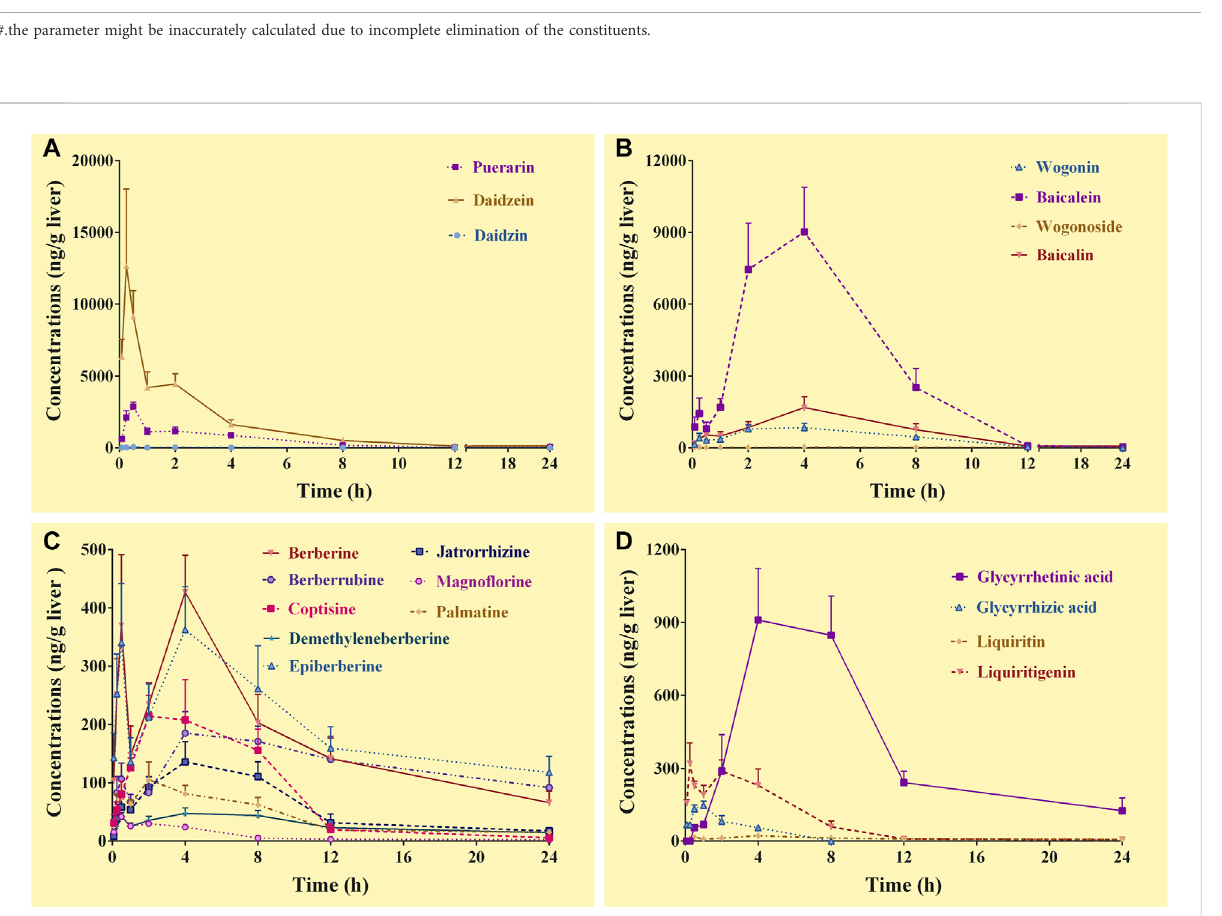
FIGURE 3 Concentration-timecurvesoftheconstituentsof Gegen - Qinlian decoctionintheliversofthemicereceivedtheoral Gegen - Qinlian decoction atthedosageof6.1 g/kg(mean±SD,n=6). (A) ,constituentsderivedfrom PuerariaeLobataeRadix ; (B) ,constituentsderivedfrom ScutellariaeRadix ; (C) , constituents derived from Coptidis Rhizoma ; (D) , constituents derived from Glycyrrhizae Radix Et Rhizoma Praeparata Cum Melle